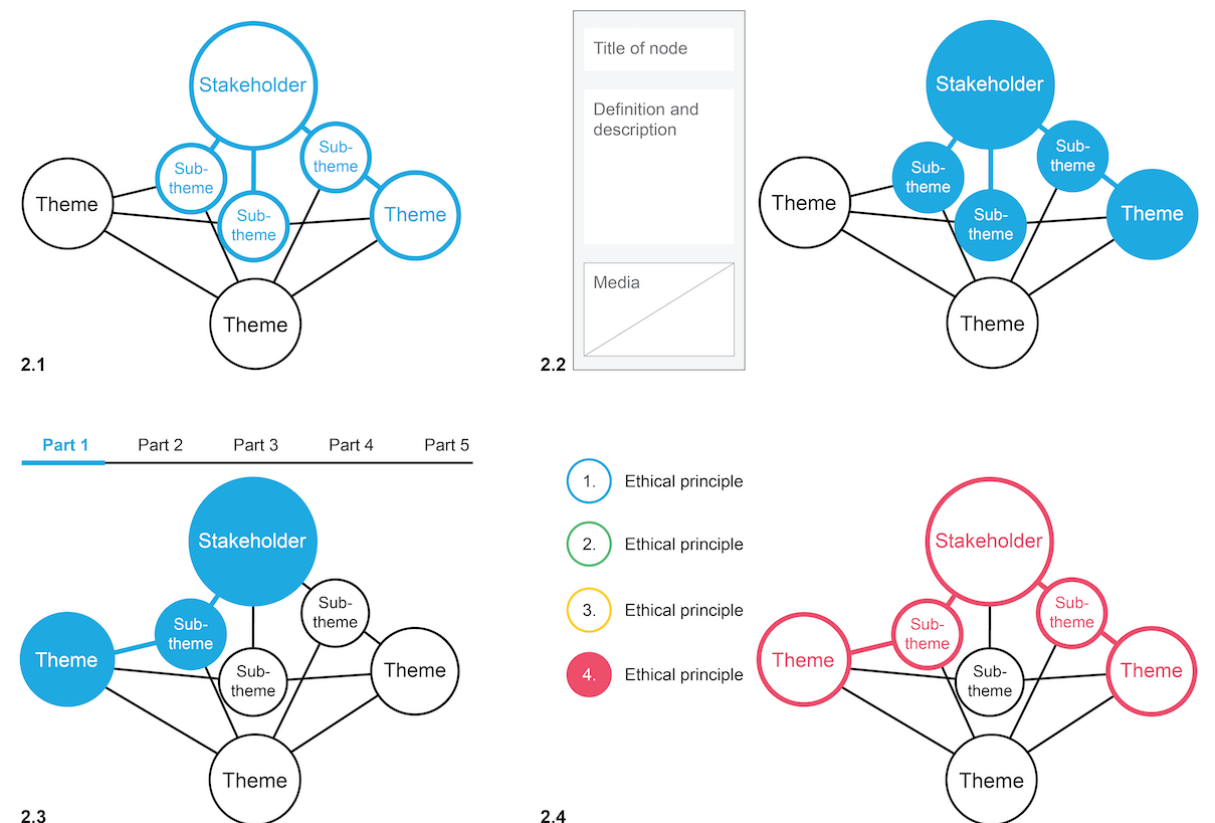
Figure 2. In image 2.1, we see the effect of hovering over a node that highlights connections. Image 2.2 shows the function of clicking to access information and metadata. Image 2.3 depicts the buttons that represent the stakeholder perspectives and the node highlighting in the map below as response when one of them is activated. Image 2.4 demonstrates the function of highlighting ethical principles using the color legend simultaneously to the other functions where each color corresponds to an ethical